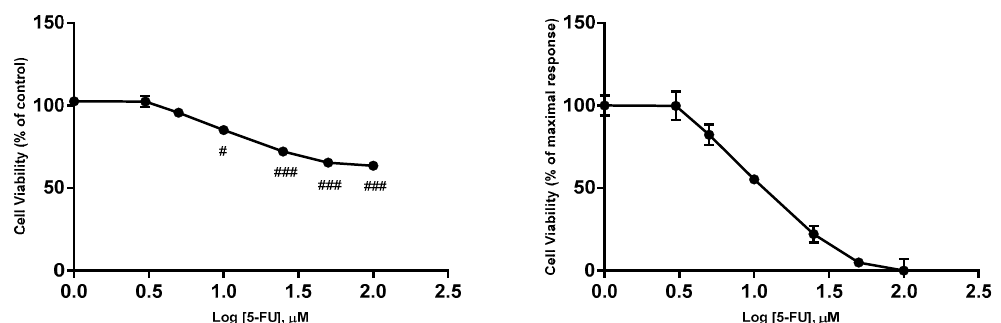
Figure 3. Concentration-effect curves obtained for 5-FU. The drug was added in fresh medium, in sextaplicates. Results are presented as mean ± SEM of three independent experiments. The left curves represent the viability of cells (% of control), whereas the right curves represents a normalization between 0 and 1 (0% and 100%), where 100% was defined as the concentration of the drug that less affected the cell viability, and all other data points were normalized to this value, being 0% defined as the concentration that affected more the cell viability. ### p < 0.001 and # p < 0.05 vs. control.